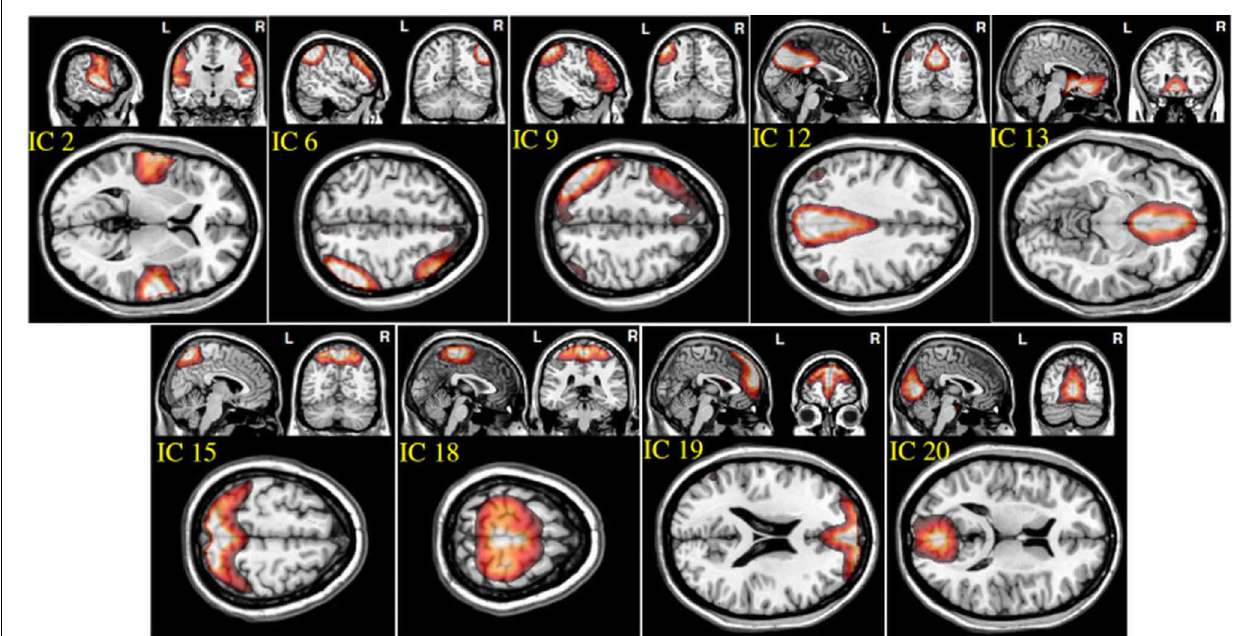
FIGURE 2 | Spatial maps of the nine selected IC